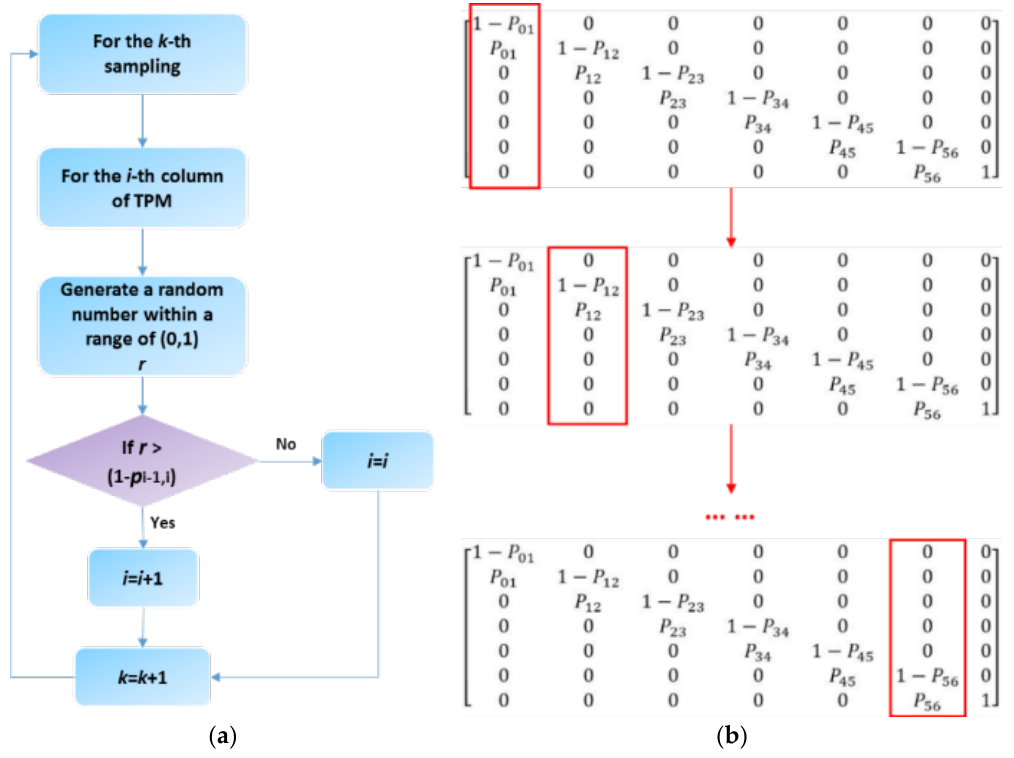
Figure 1. Illustration of fundamental theory of the discrete Markov chain model. ( a ) Flow chart; ( b ) Scheme of randomly sampling.